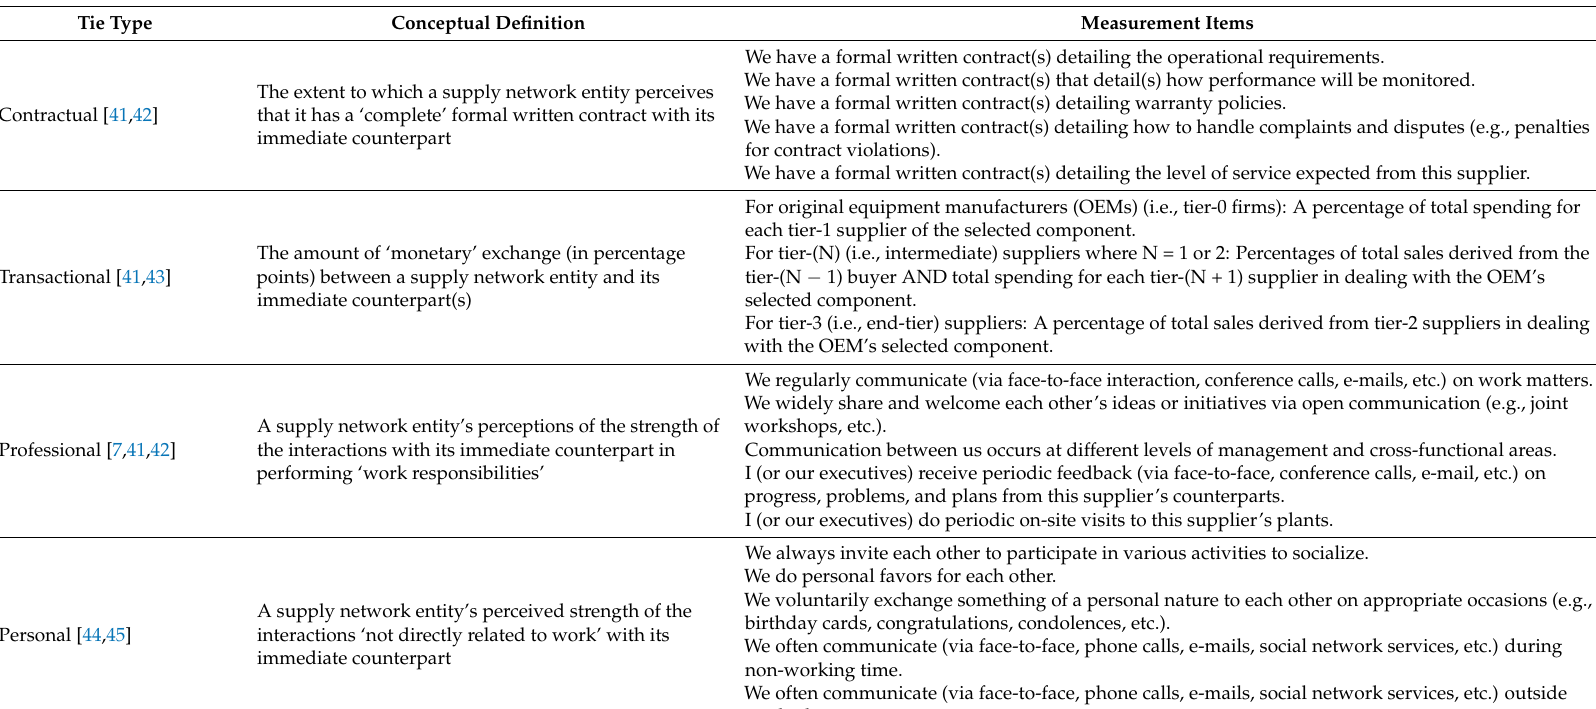
Table 1. Conceptual definitions, item measures, and related literature for supply network tie